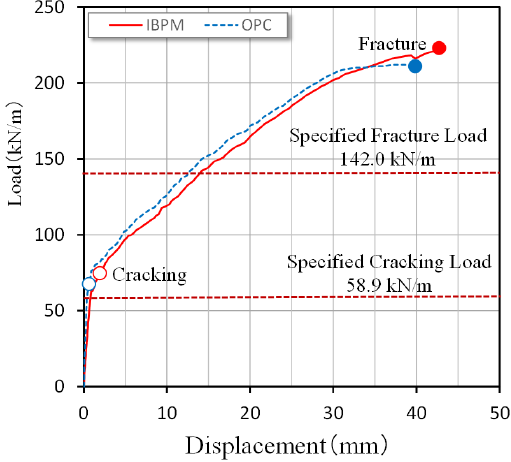
Figure 15. Road versus displacement relationship (Hume pipe